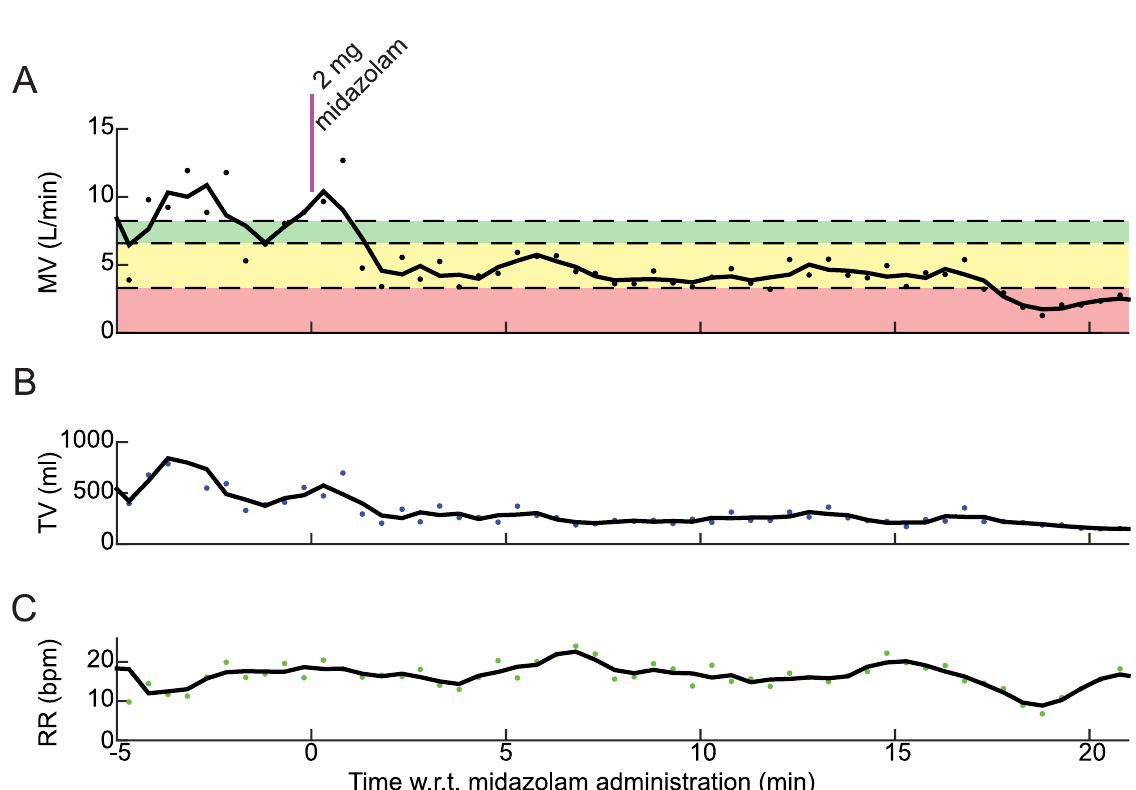
Fig 4. A time-lapse capturing one representative patient’s onset of respiratory depression during the 20 minutes following the administration of midazolam. Note that this is the same patient as in Fig 3A and 3B (31 y/o male). MV and TV decrease about 3–4 minutes after the dose and remain low as comparedto pre-dosevalues, whereasRR increasesand remains above